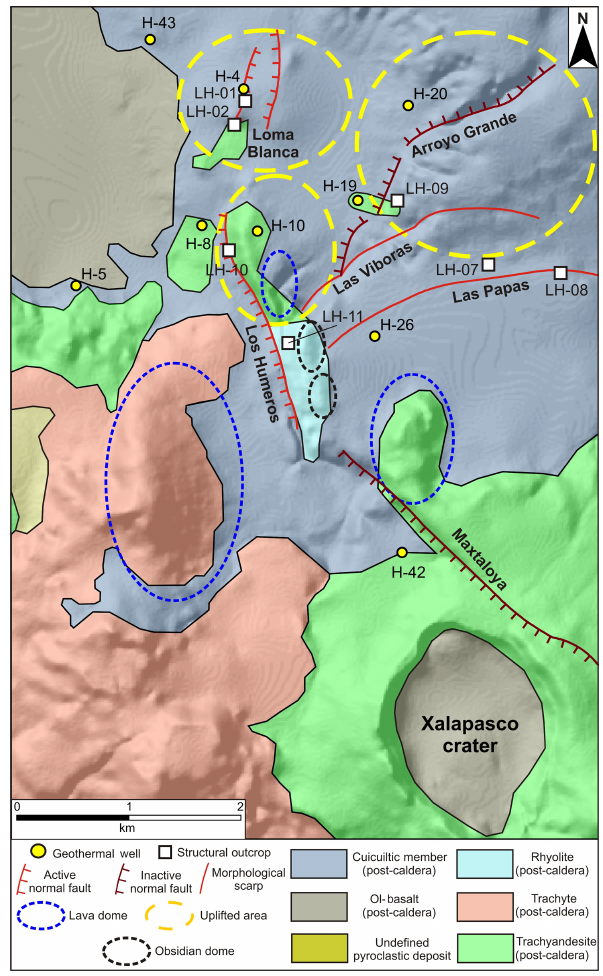
Figure 4. Simplified geological structural map of the studied area (reinterpreted after Norini et al., 2015; Carrasco-Núñez et al., 2017a; Calcagno et al.,